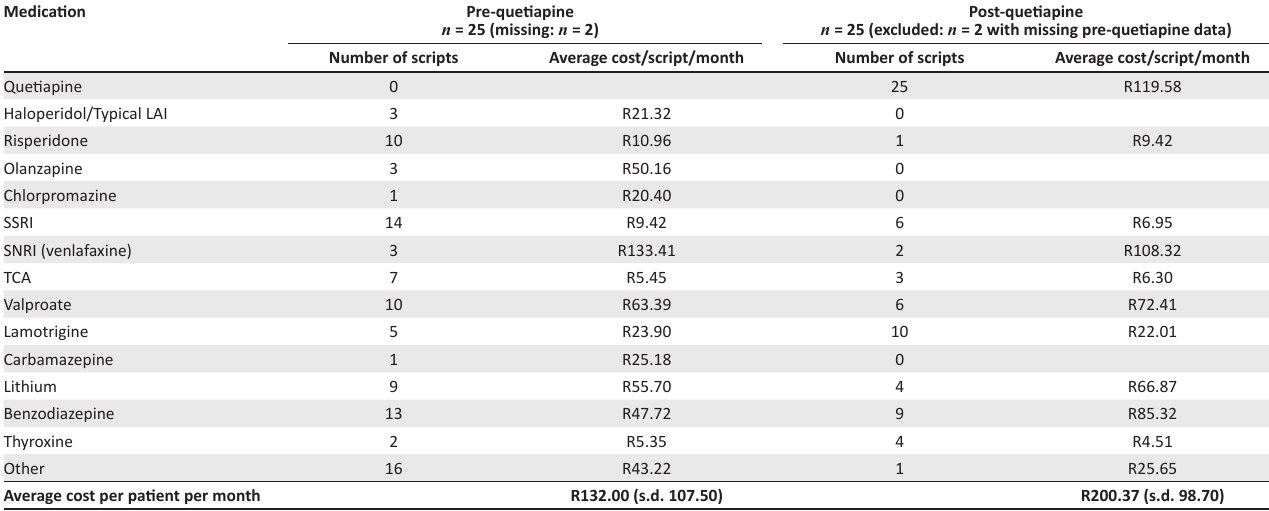
TABLE 4: Average pre-and post-quetiapine medication cost per patient (responder). Medication Pre-quetiapine n = 25 (missing: n =